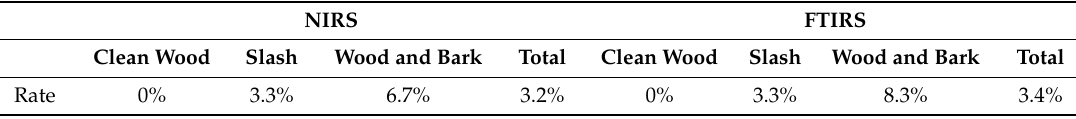
Table 4. Five-fold cross-validation summary of error count estimates (%) for plant part component 1